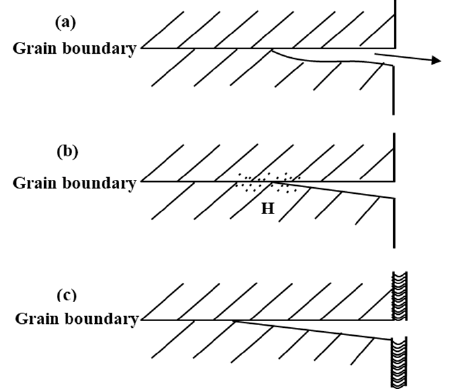
Figure 7. Illustration of mechanisms of SCC for aluminum alloys. ( a ) Anodic dissolution assisted cracking; ( b ) Hydrogen induced cracking; ( c ) Passive film rupture. (Reprinted with permission from ref. [65]. Copyright 2016 Elsevier).